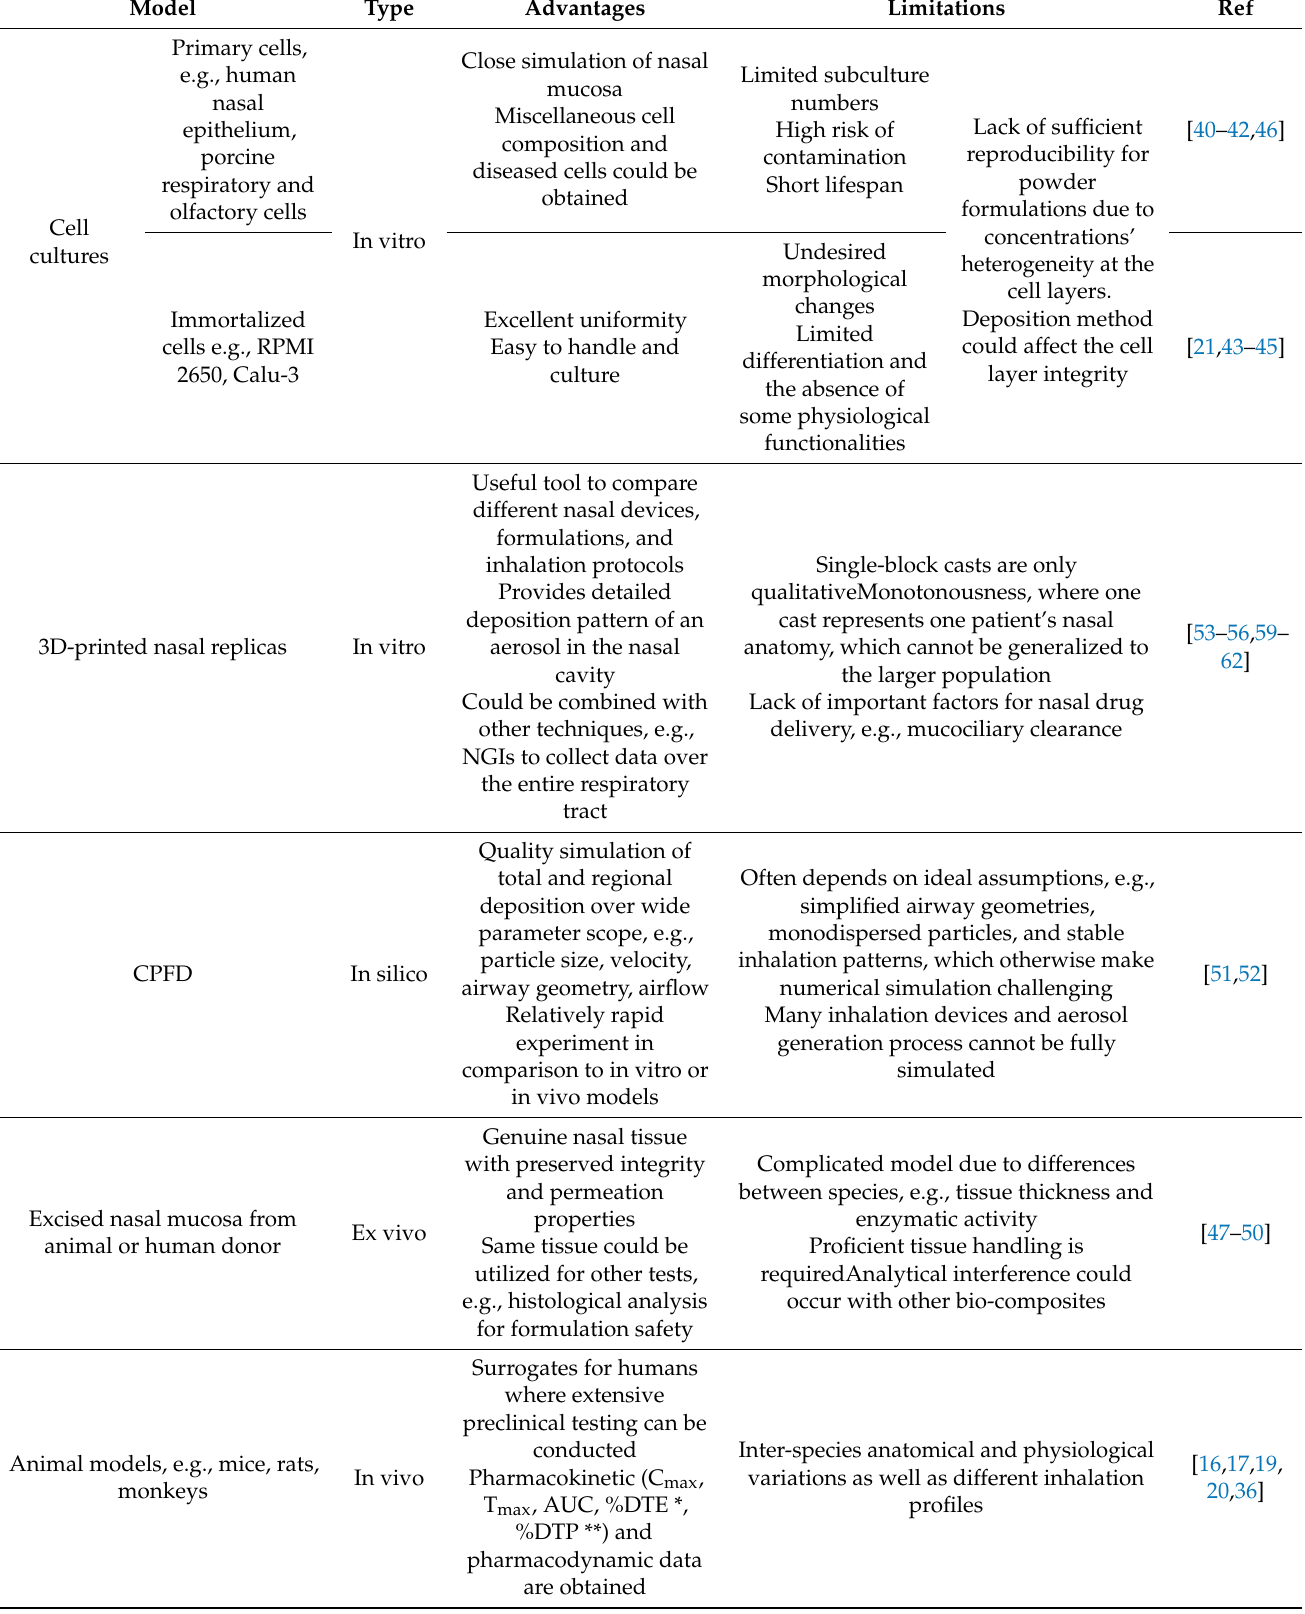
Table 1. Preclinical models used for nasal formulations and device